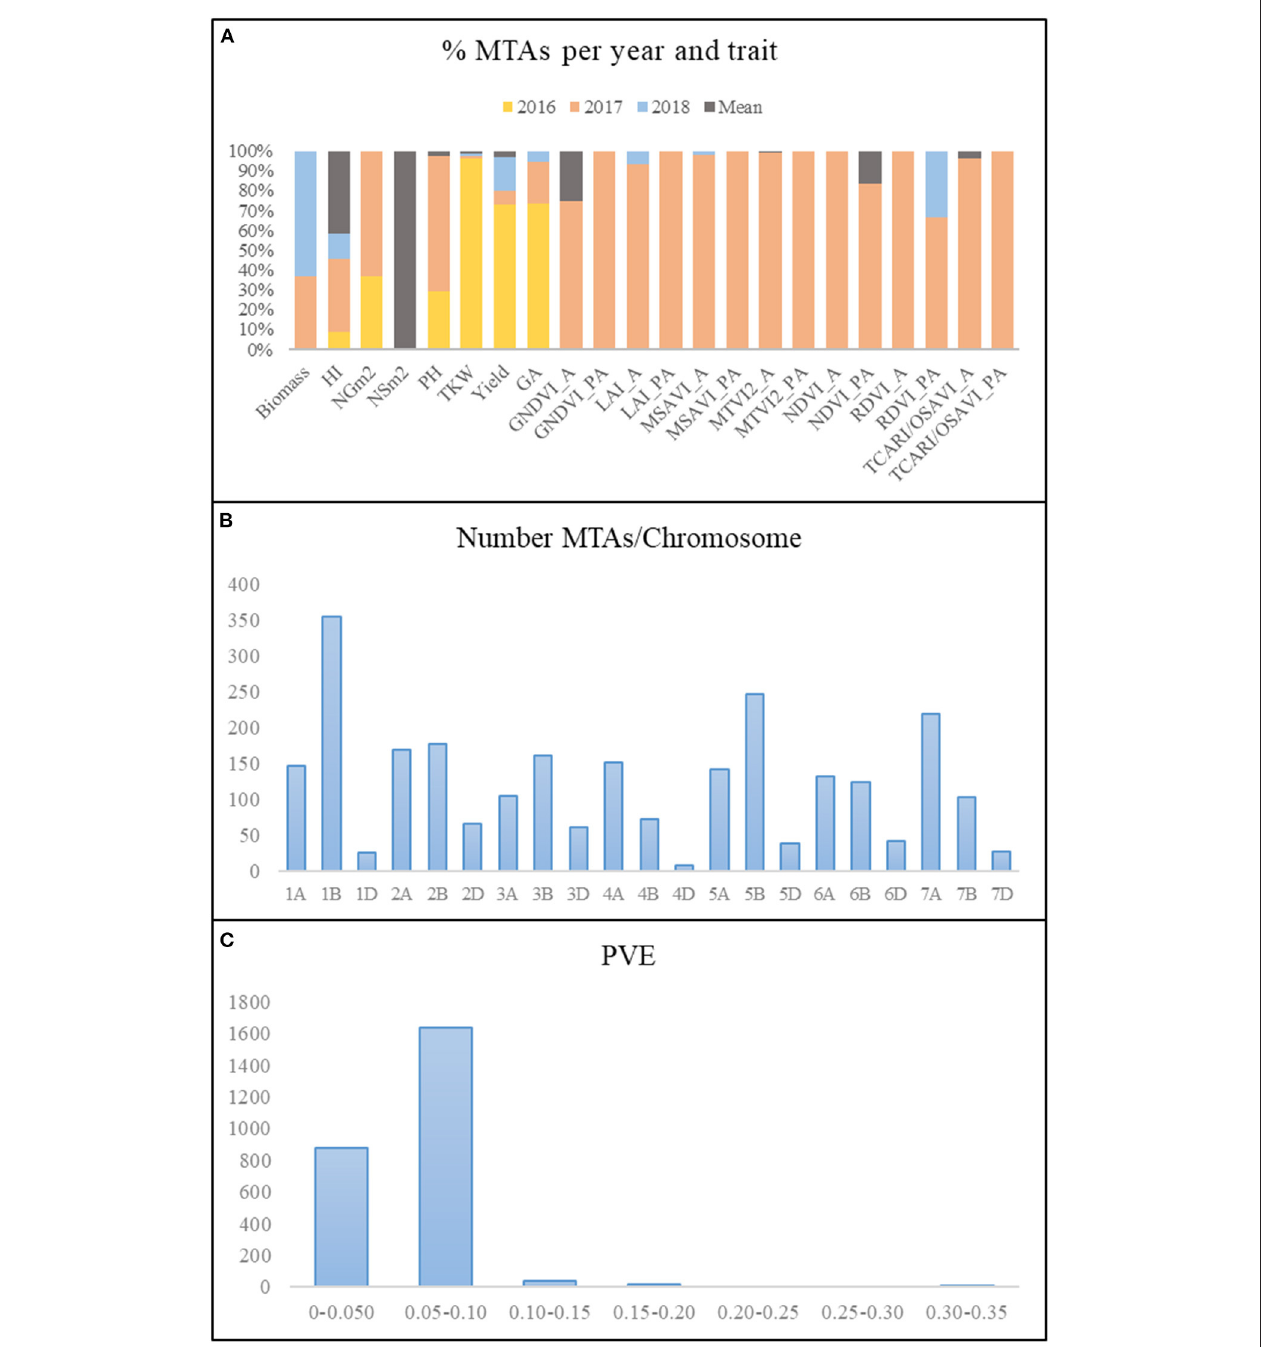
FIGURE 4 | Summary of MTAs. (A) Percentage of MTAs per year and trait. (B) Number of MTAs per chromosome. (C) Phenotypic variance explained (PVE). MTAs, marker–trait associations; HI, harvest index; LAI, leaf area index estimated by MTVI2; NSm 2 , number of spikes per square meter; NGm 2 , number of grains per square meter; TKW, thousand kernel weight (g); PH, plant height; GA, green area from emergence until the first node; A, anthesis stage; PA, postanthesis.